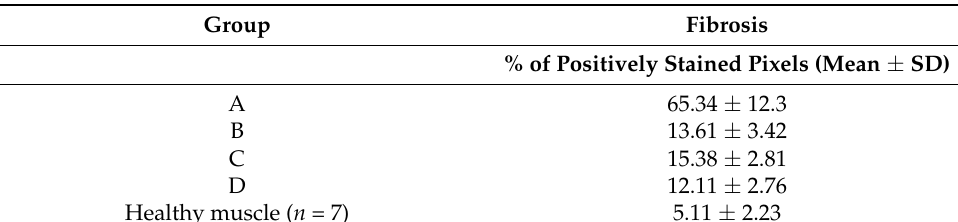
Table 2. Automated analysis of fibrosis of muscle samples.